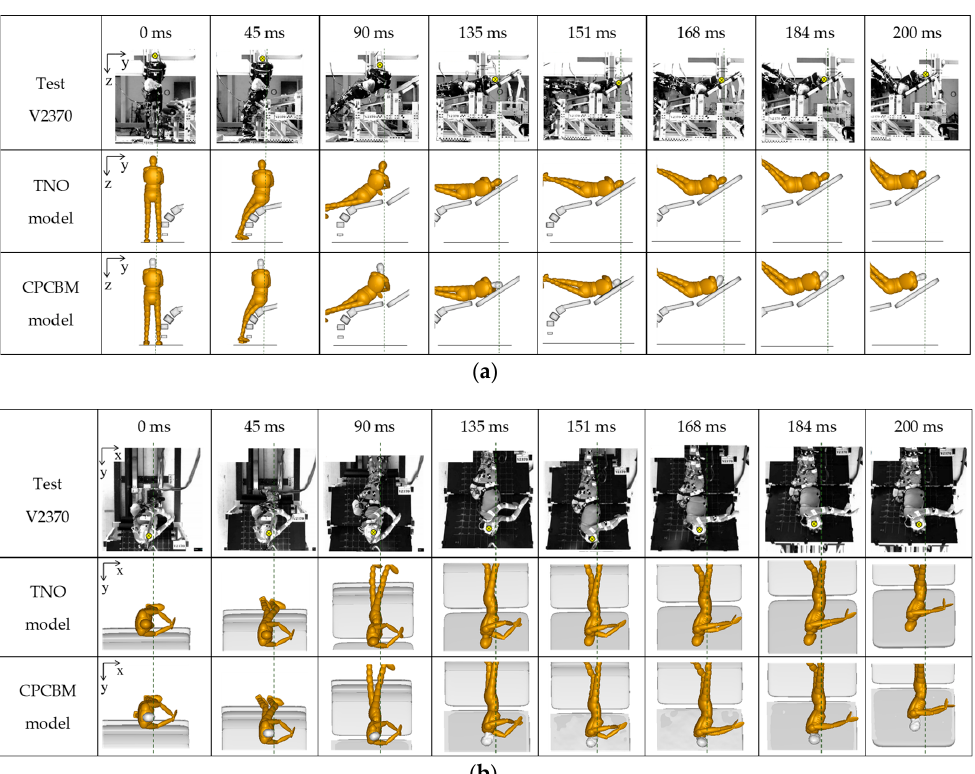
Figure 5. Overall kinematics comparison for test V2370 [17] between the TNO model, CPCBM, and the experimental data: ( a ) posterior view, ( b ) superior